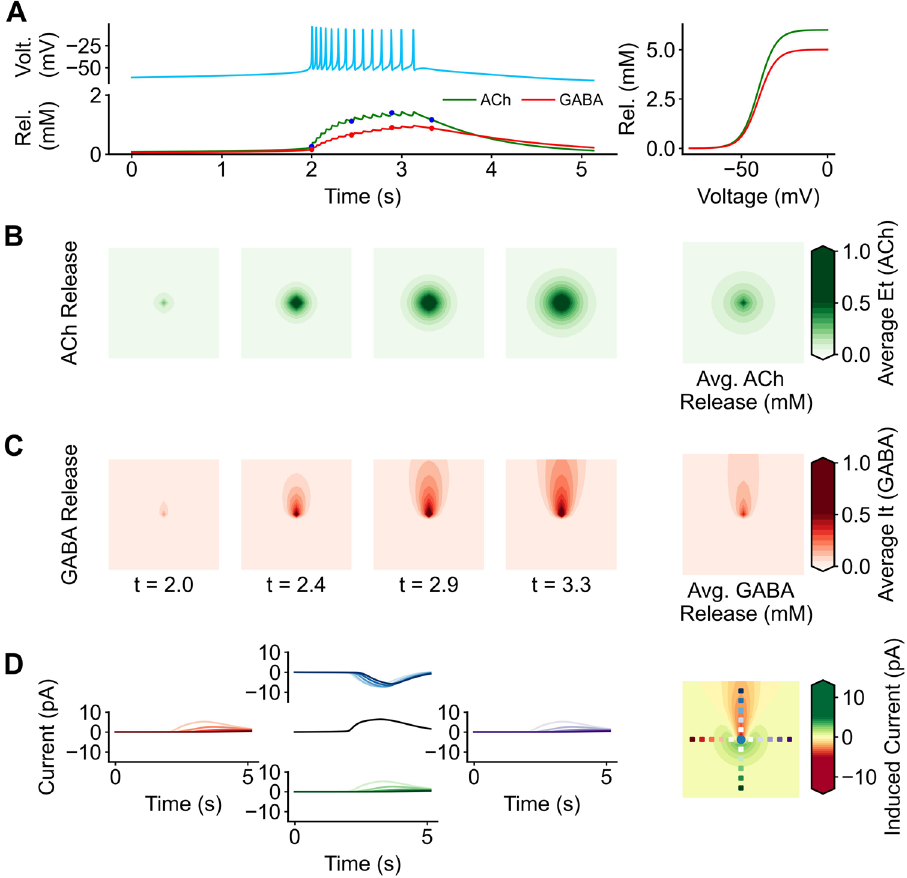
Figure 5. Neurotransmitter dynamics and synchronization. Neurotransmitter release alters the dynamics of the model and allows for cell to synchronize. ( A ) As the voltage ( V t ) increases over time, acetylcholine ( E t ) and GABA ( I t ) are released from the cell according to a sigmoidal function (right panel). This release does not only occur in a temporal manner, but also in a spatial manner. ( B ) Acetylcholine and ( C ) GABA are both released from a central point, but they have different spatial distributions. (B5) and (C5) These values are averaged over time to get a profile of acetylcholine and GABA respectively. ( D ) Cells are sampled at 6 separate sampling spots. Plotted are the currents induced if the receiving cell were to be located at each one of the sampled spots. A spatial profile of induced current by the single cell was made by taking the average currents from the acetylcholine and GABA